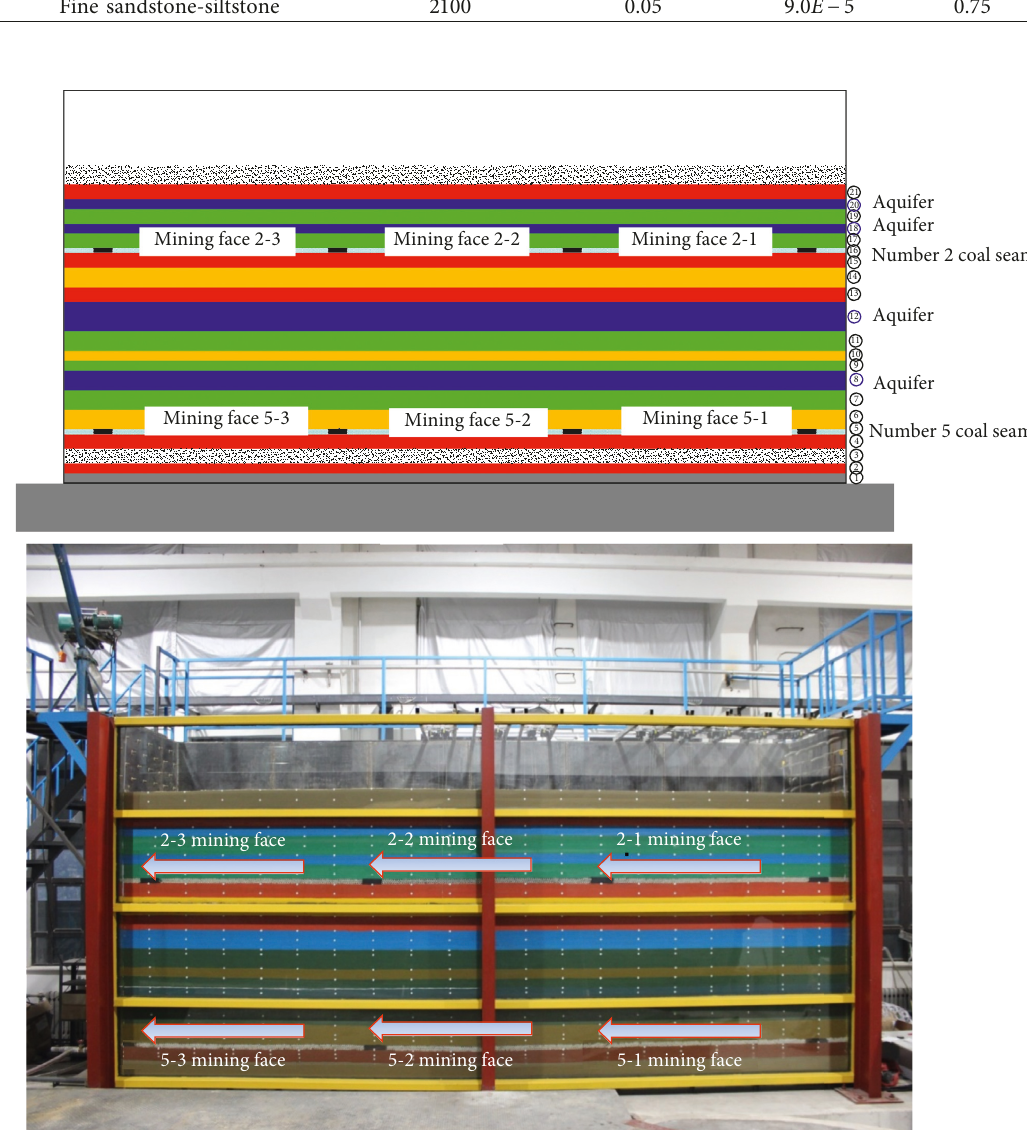
Figure 1: Cross section of the physical simulation